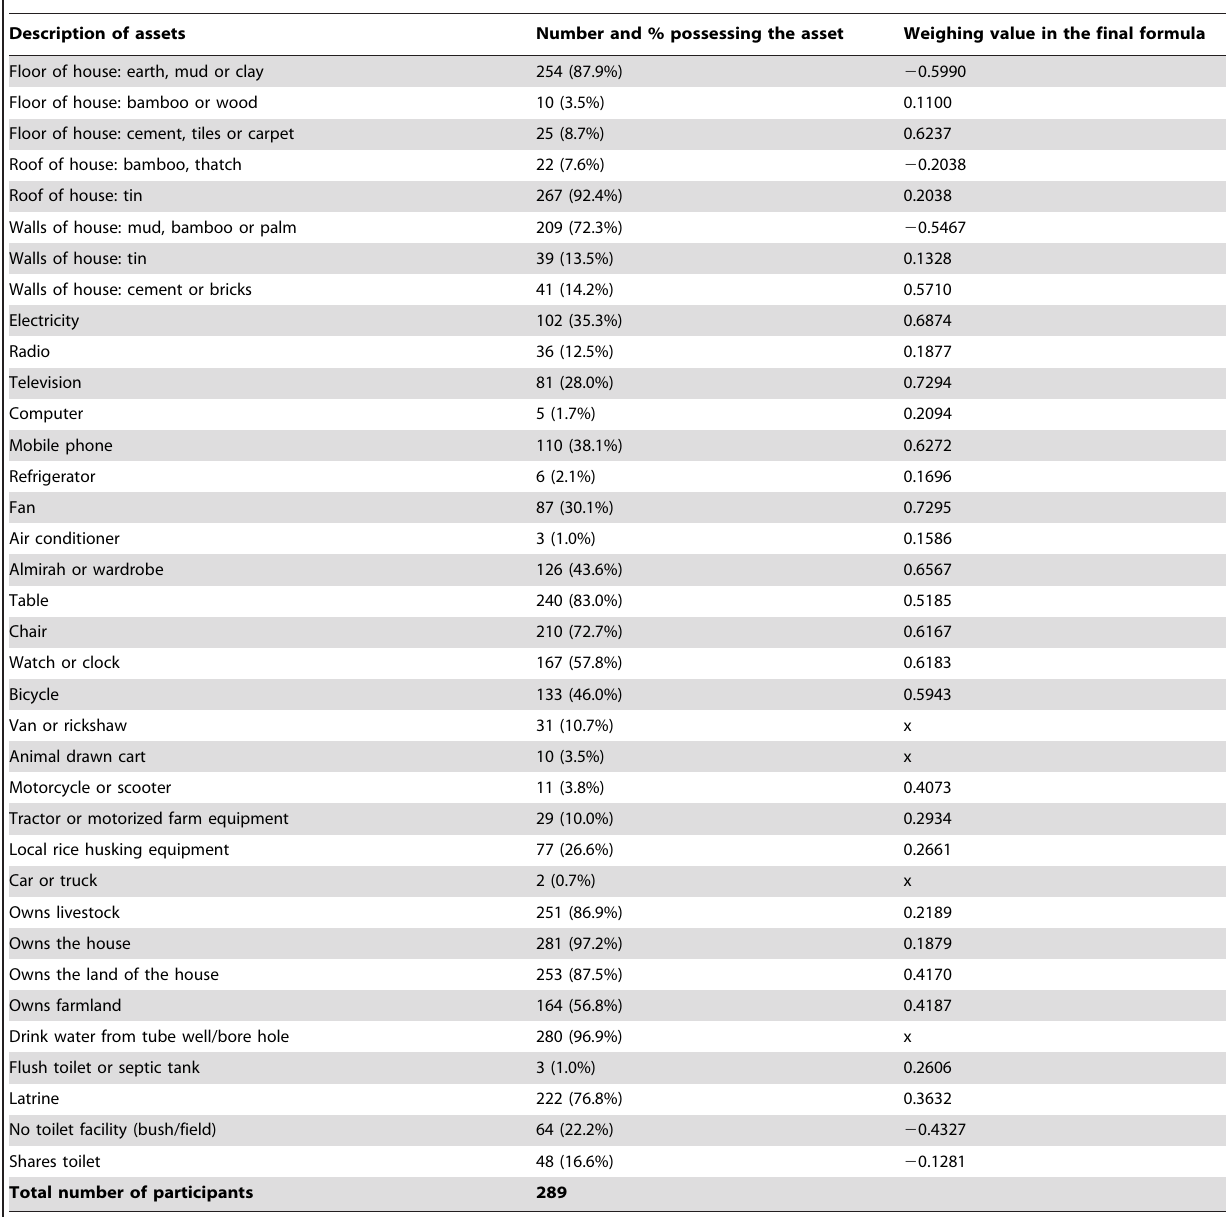
Table 1. Variables in the asset index with weighing value as obtained by factor analysis (first factor).